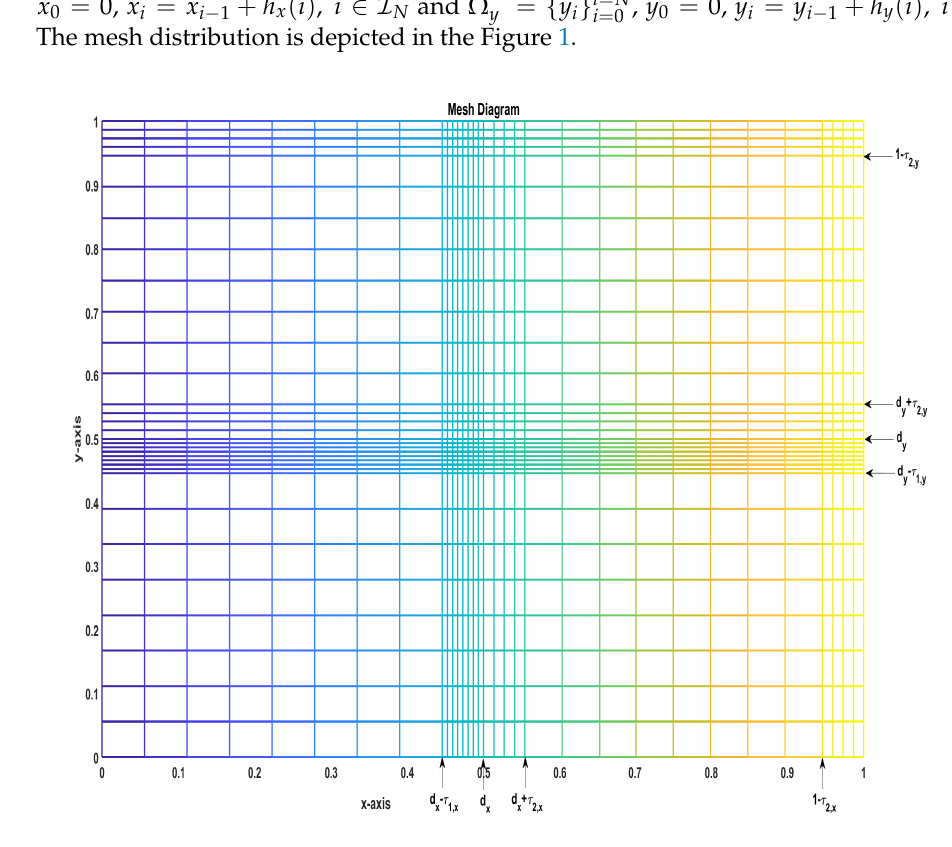
Figure 1. Mesh points